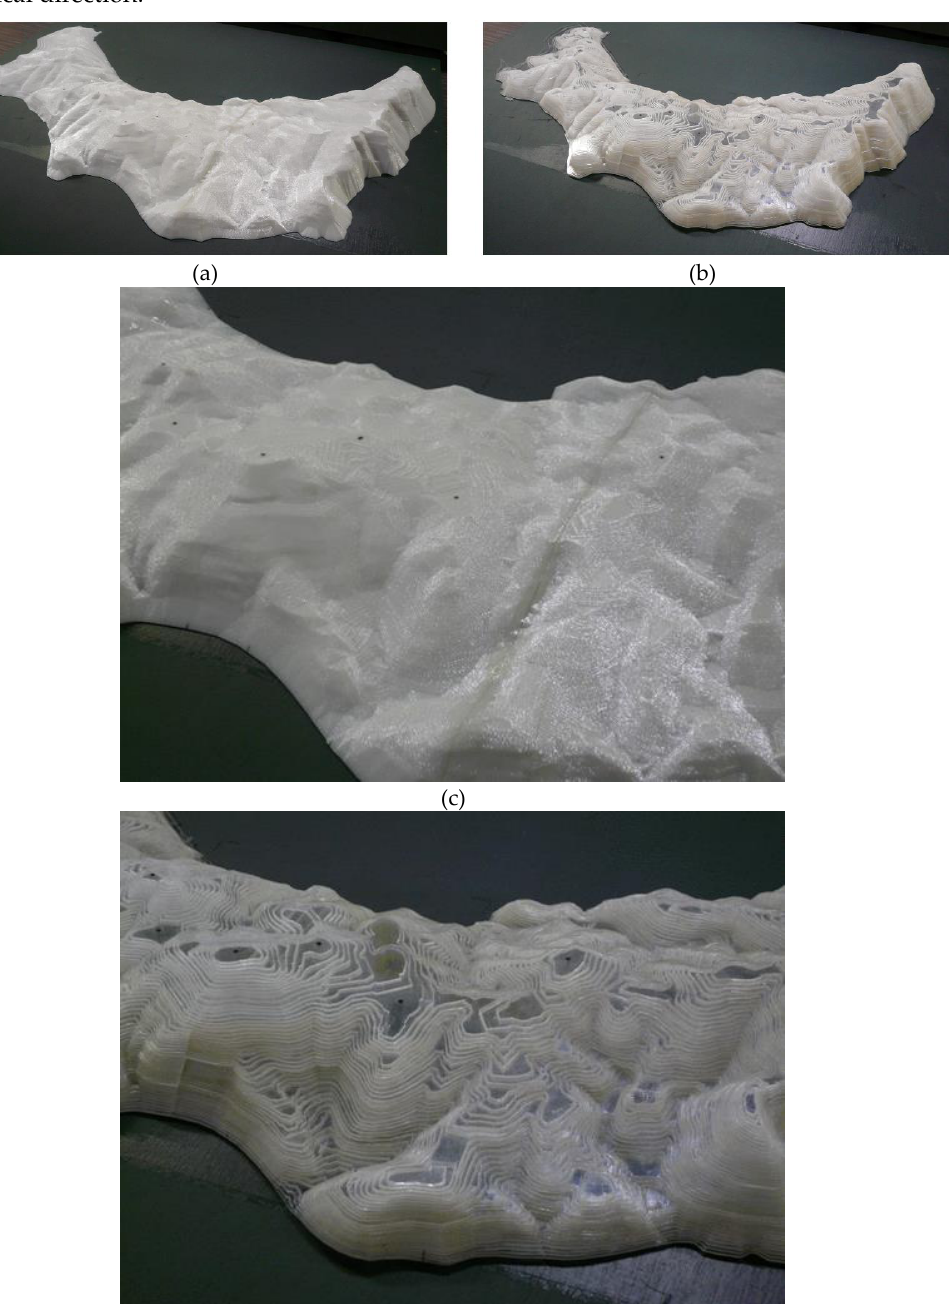
Figure 17. Comparison of whole and enlarged views of the scale model: (a,c) Scale model without irregularities made from polycarbonate, and (b,d) scale model with irregularities made by stacking 1 mm-thick acrylic plates.